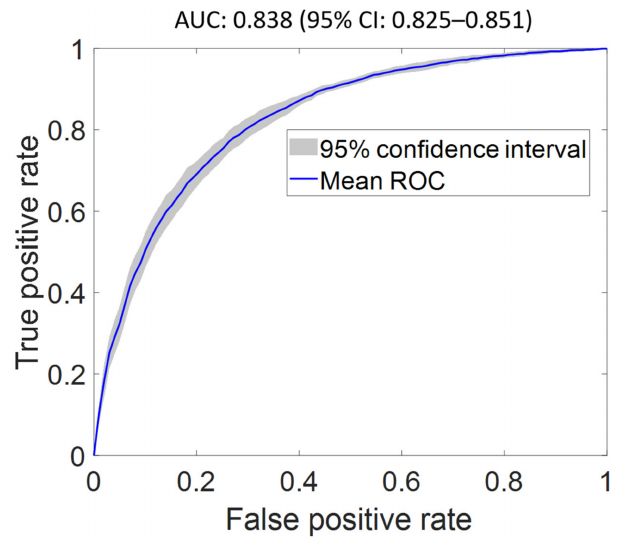
Figure 2. Optimal receiver operating characteristic curve of heart failure classifier using the optimal feature set (FS2) as input. The proposed model achieved an AUC of 0.838 (95% CI: 0.825–0.851), which is superior to the AUC of the classifier using all features (FS1) as